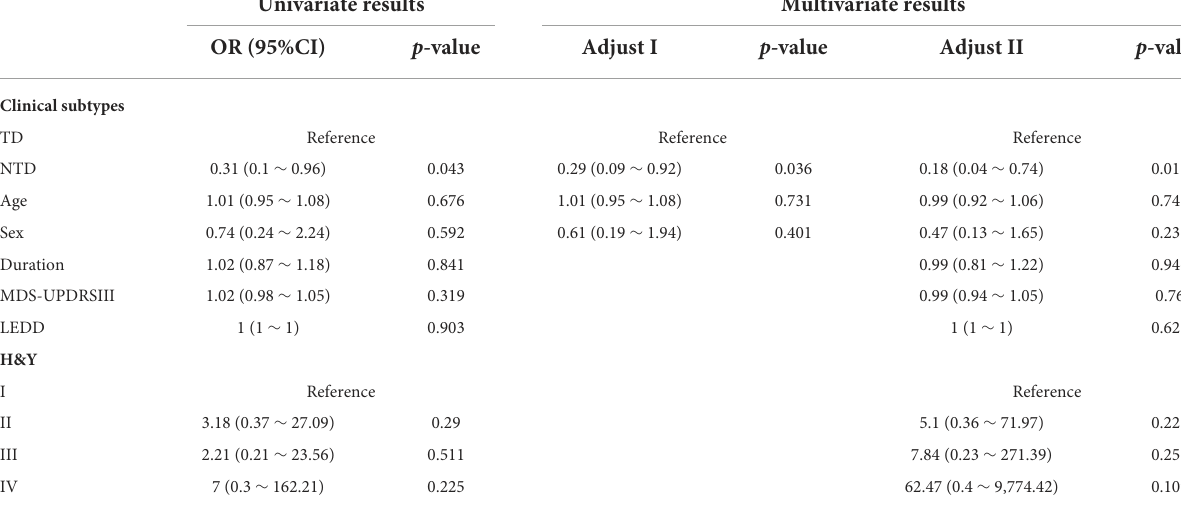
TABLE 6 Univariate and multivariate analysis for the association between velocity and possible factors. Univariate